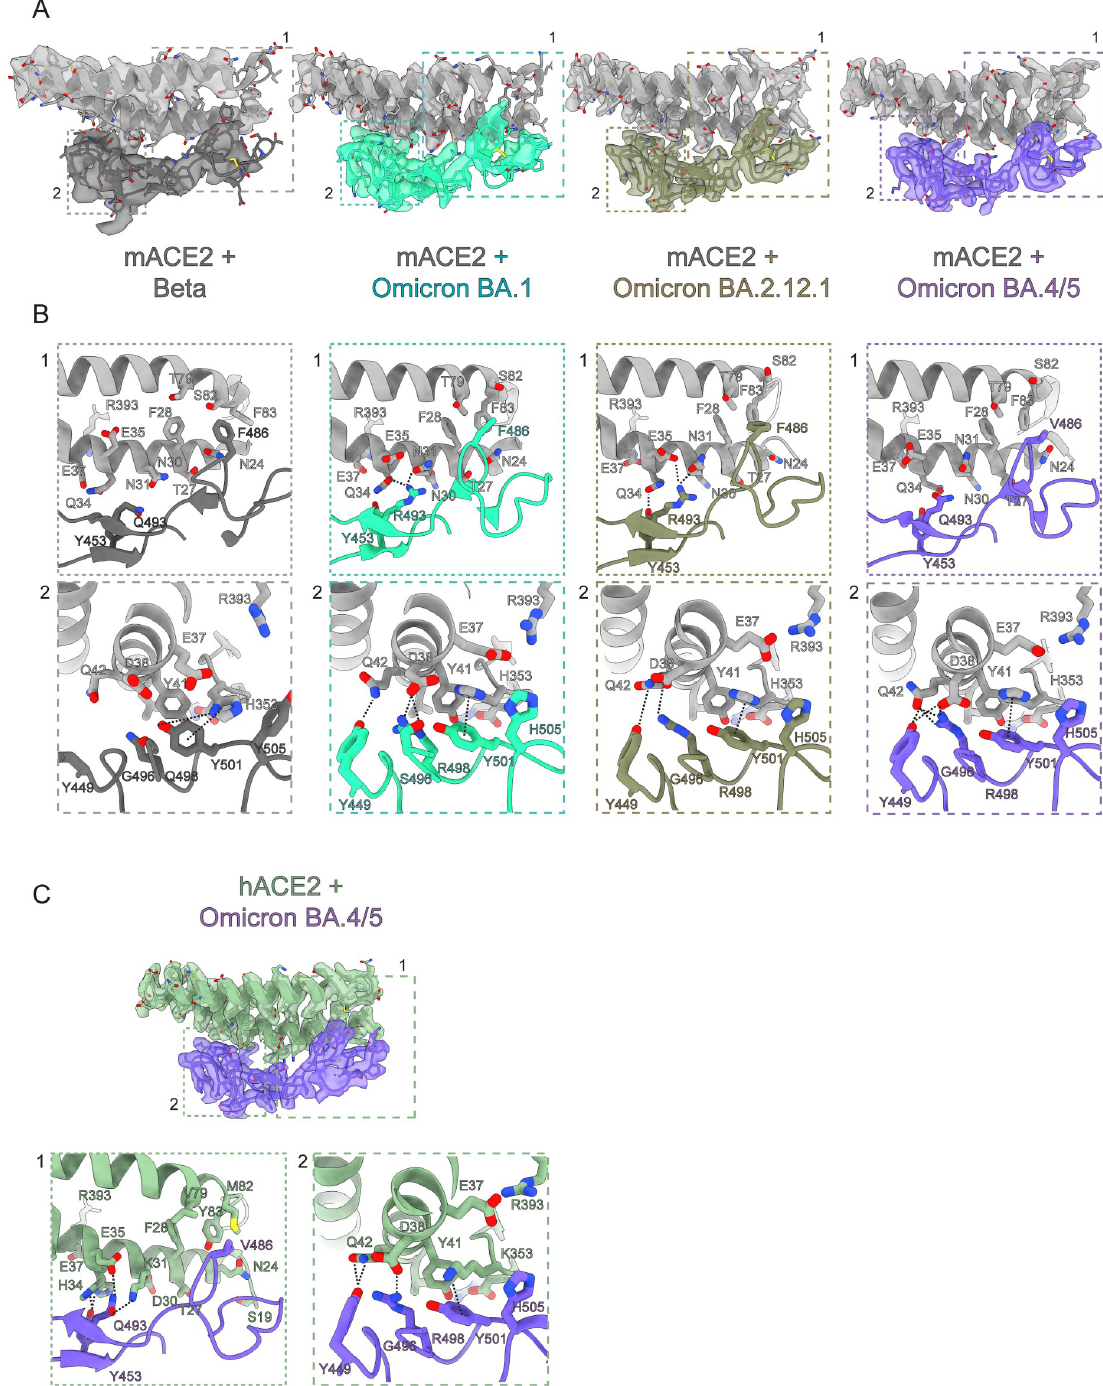
Fig 4. Structural basis of mACE2 binding to variants of concern and of hACE2/BA.4/5. (A) Zoomed view of the binding interface between mACE2 and RBD of variants of concern with cryo-EM densities. (B) Highlighted views of specific interaction sites of patch 1 and patch 2 as indicated in (A). (C) Zoomed view of the binding interface between hACE2 and RBD of variants of concern with cryo-EM densities with highlighted views of specific interaction sites.